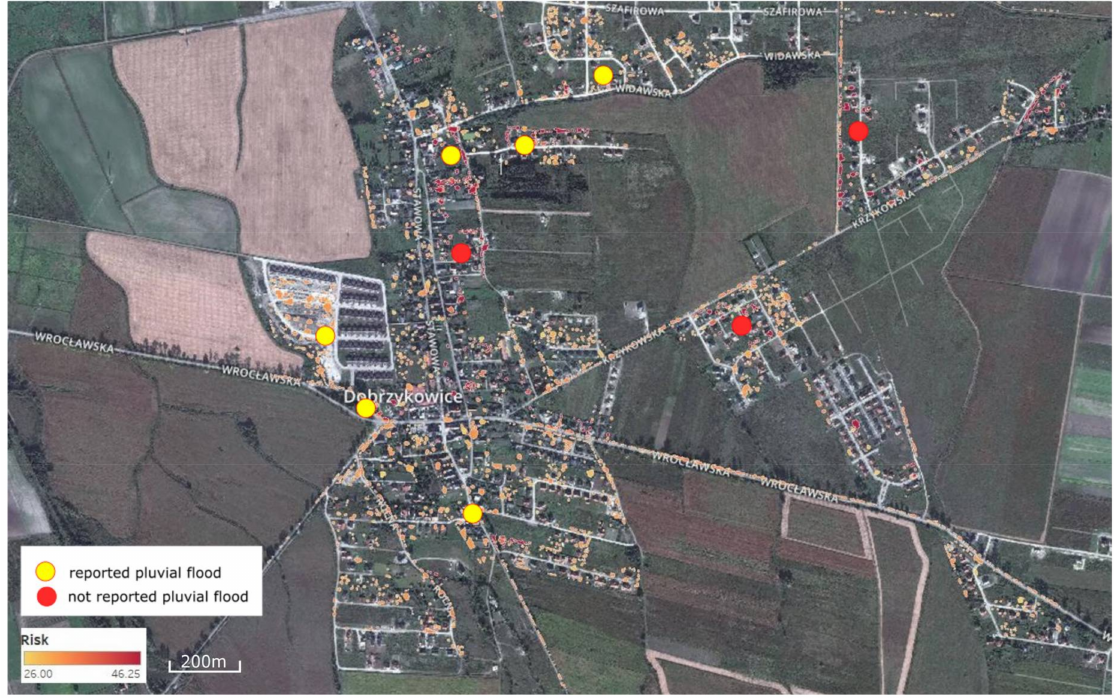
Figure 7. Spatial distribution of built-up parcels with a maximum pluvial flood risk scores of